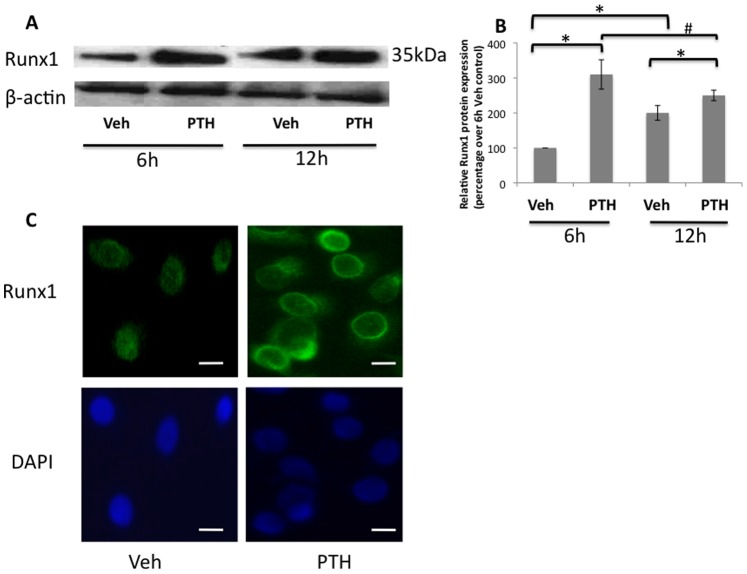
Up-regulation of Runx1 expression by PTH in limb bud mesenchymal progenitor cells.(A) Western blot analysis reveals that 6 hours and 12 hours of PTH treatment increased Runx1 protein levels in the limb bud cells, compared to DMSO (Vehicle control). β-actin was used as a loading control.(B) Quantification of Runx1 protein expression in Western blots. Data are means ± SD of three independent experiments. (*p<0.05 compared with control at same time point, #p<0.05 compared with PTH at 6 h). (C) In vehicle-treated controls endogenous Runx1 is localized to nuclear areas. Markedly increased peri-nuclear and nuclear labeling of Runx1 was visible in limb bud cells after treatment with PTH for 6 hours. Cells were counterstained with DAPI (blue). Scale bars, 5 µm.